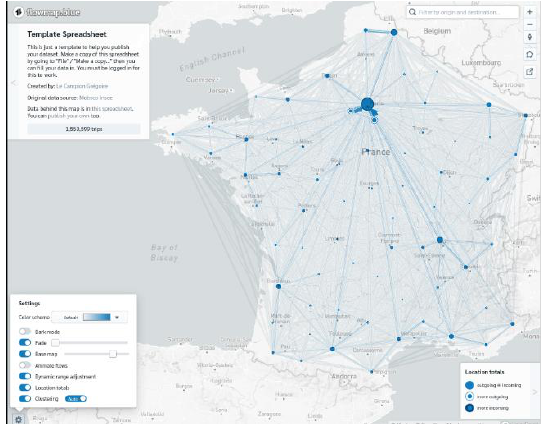
Figure 5 . Flowmap.blue